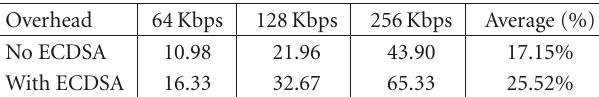
Table 8: Charging overhead (in Kbits) versus bitrate and usage of cryptographic